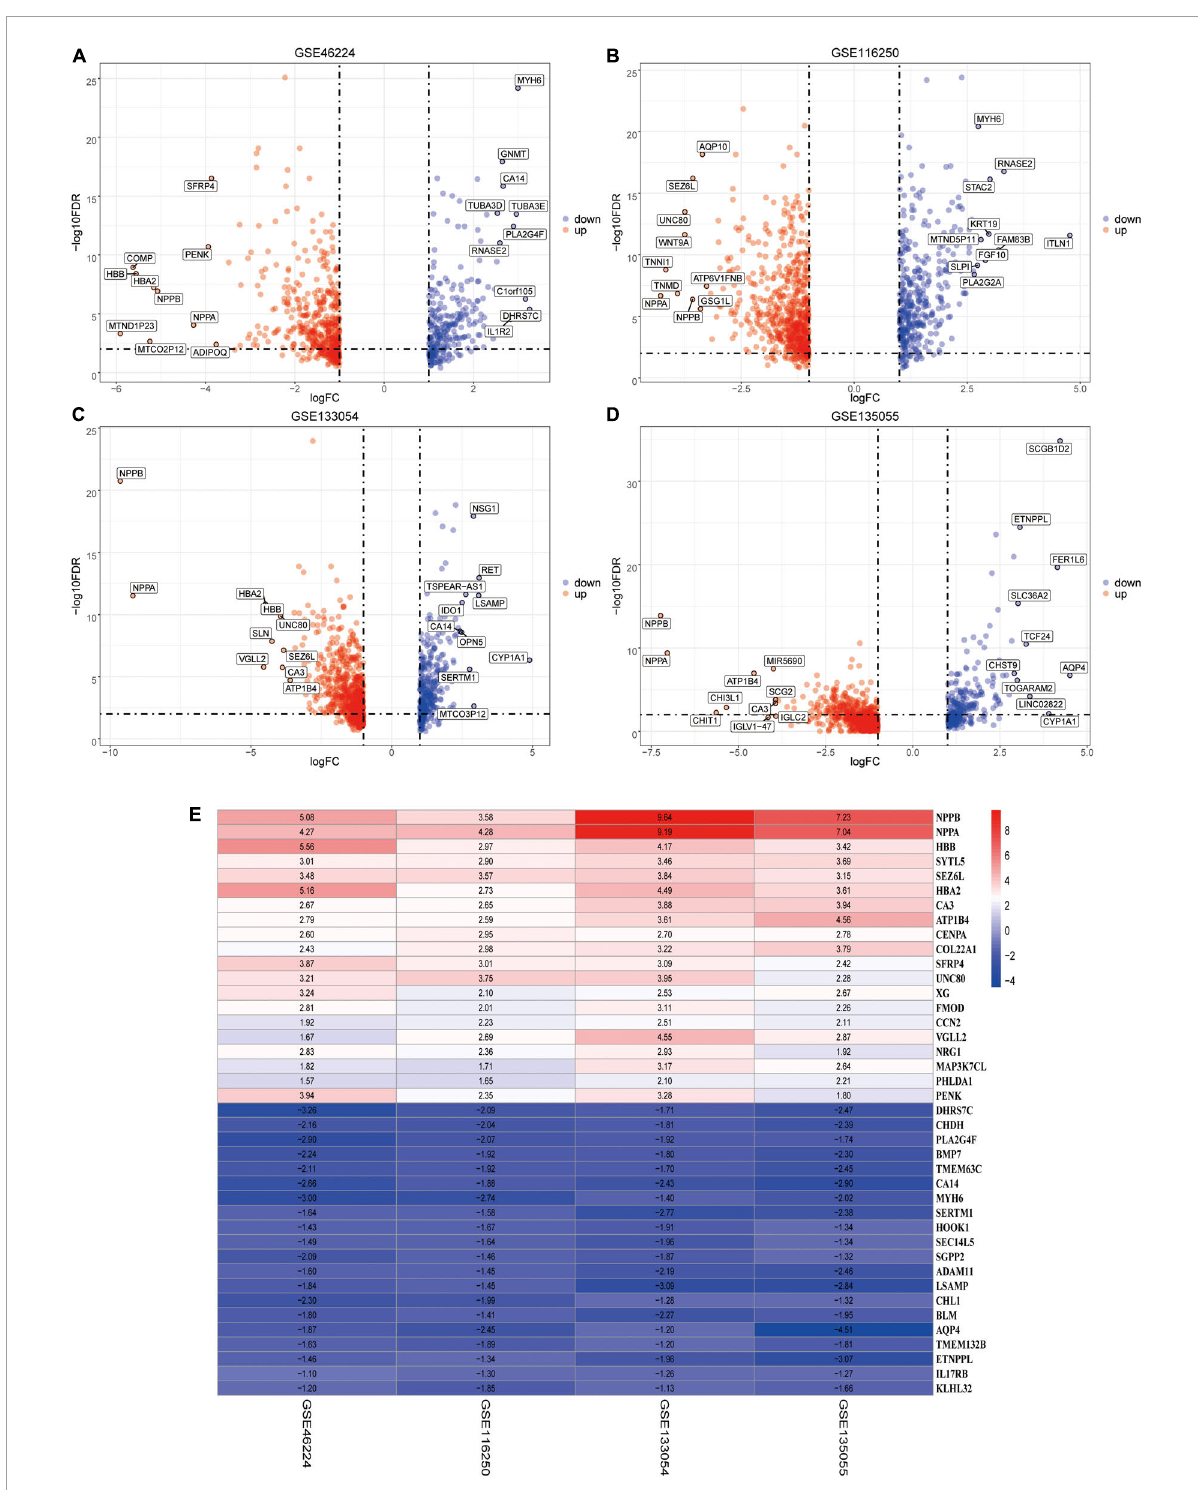
FIGURE5 Identification of DEGs by RUVSeq and the RRA method. (A–D) Using RUVSeq package, DEGs (patients with HF vs. NFDs) were screened in the four selected RNA-seq datasets GSE46224 (A) , GSE116250 (B) , GSE133054 (C) , and GSE135055 (D) , as visualized by volcano plots. Adjusted p < 0.05 and |logFC| > 1. (E) Heatmap of the top 20 upregulated and the 20 most downregulated DEGs screened from the four selected RNA-seq datasets using RRA analysis. DEGs, differentially expressed genes; RRA, robust rank aggregation; HF, heart failure; NFD, non-failing donor; FC, fold